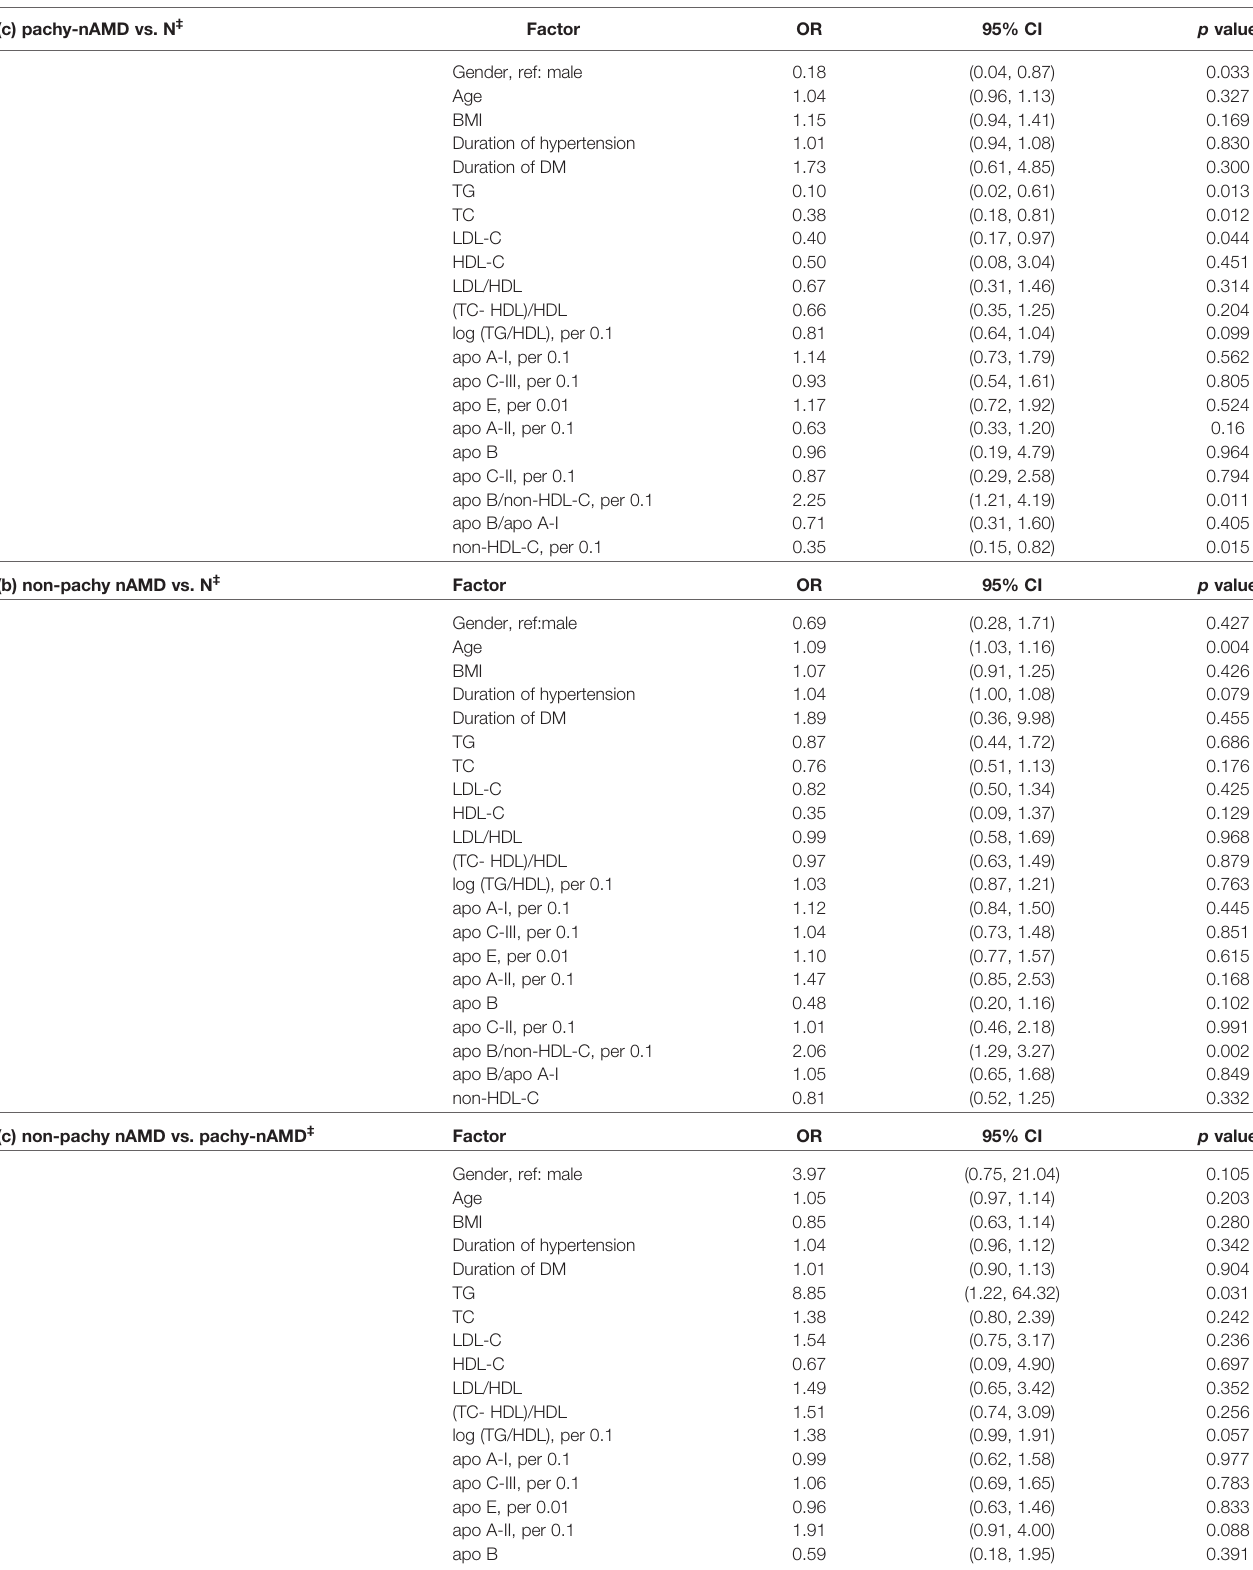
TABLE 4 | Comparisons of the variables between the sub-groups (pachy- and nonpachy-) of nAMD and control groups by univariate logistic regression analysis. (c) pachy-nAMD vs. N